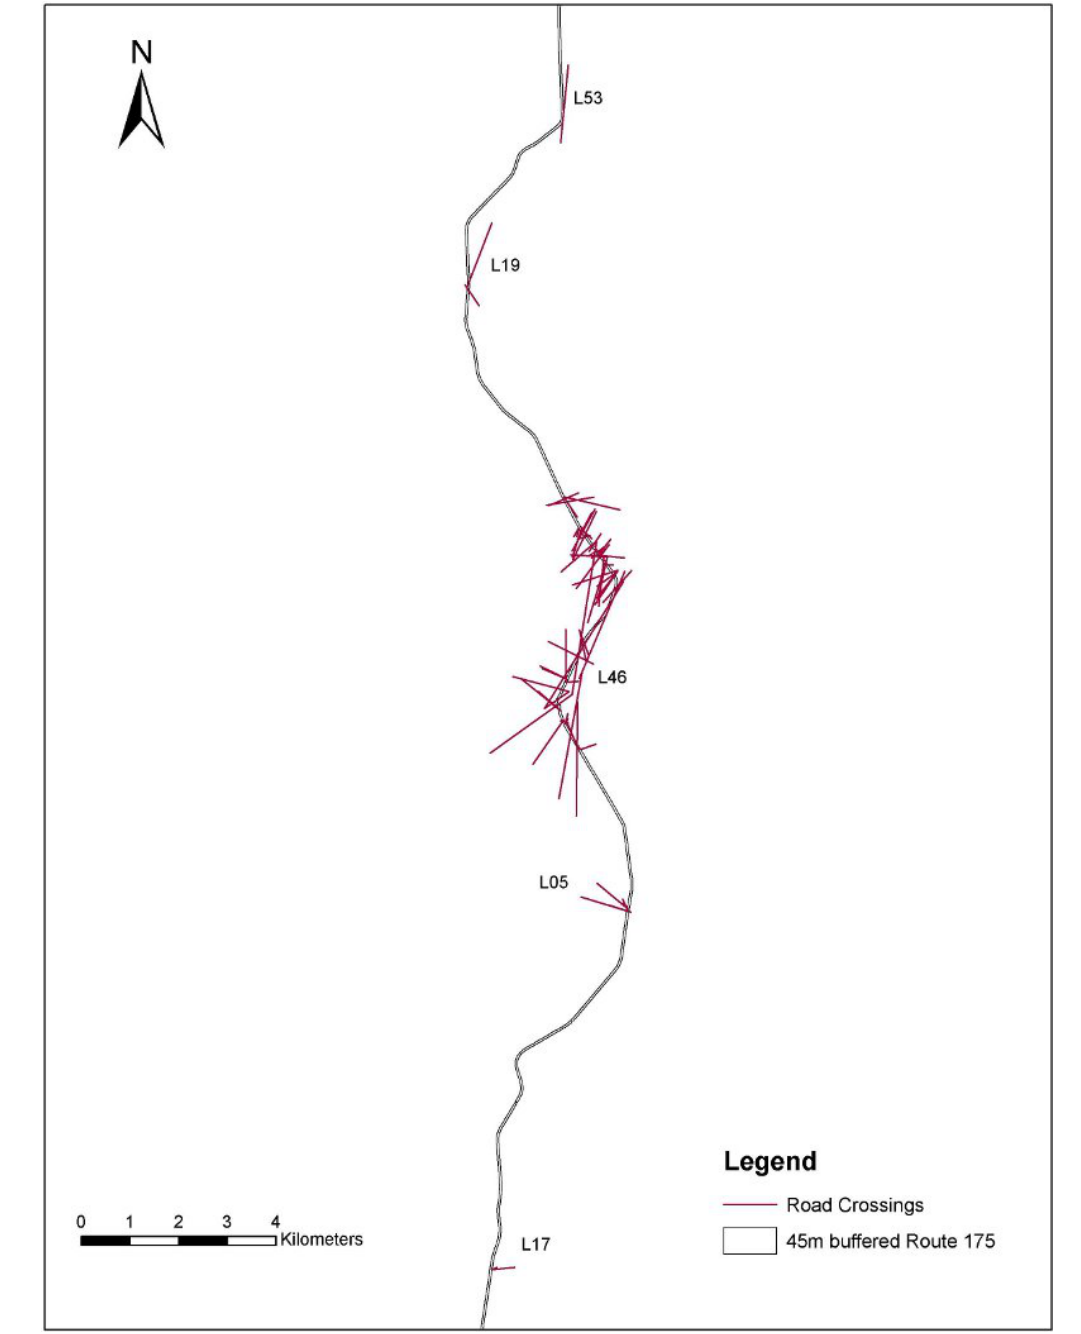
Fig. 8 . Road crossings by 12 real moose for the time period 1 May–31 August. Of the 72 paths that intersected the 45-m road buffer, 53 paths actually crossed the road. L53, L19, L46, L05, and L17 are the moose GPS telemetry collar